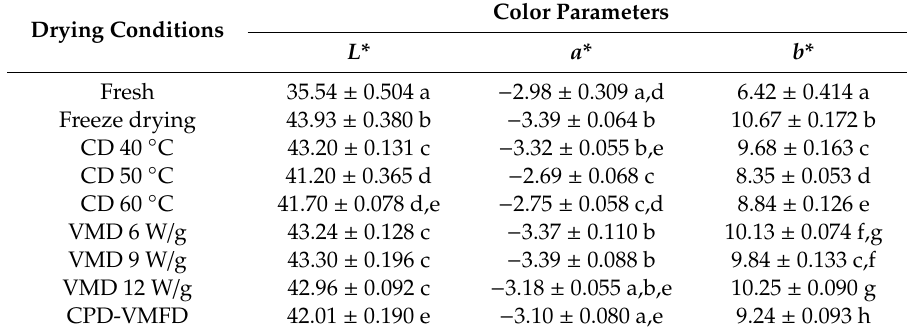
Figure 10. Image of ground S. crispus dried using FD, CD at 40, 50, and 60 °C, VMD at 6, 9, and 12 W/g, and CPD-VMFD at 50 °C and 9 W/g. Table 6. Color parameters L*, a* and b* of S. crispus affected by drying methods.